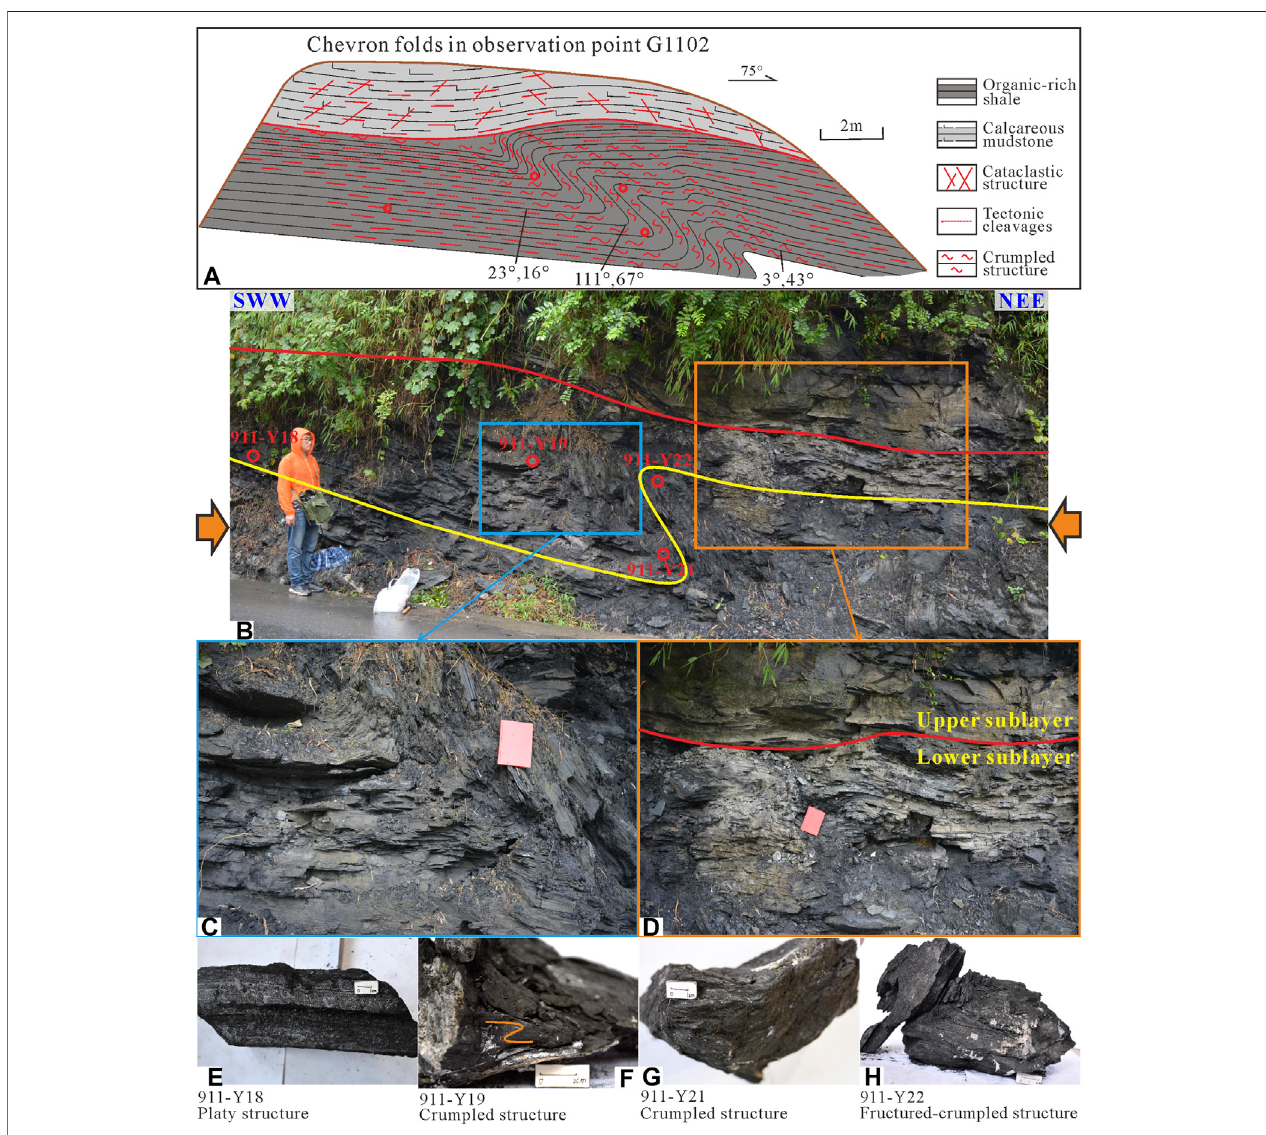
FIGURE2| Variations inshale deformationoftheupper andlowersublayersofobservation pointG1102.Notes: allattitudesofareal structural elements arein “ dip azimuth, dip angle ” format in this paper. (A,B) the geological sketch map and fi eld photograph, respectively; (C) the enlarged image of the small closed syncline; (D) the slip surface between the upper and lower sublayers; (E-H) the deformation features of shale samples with collection locations marked in A and B.